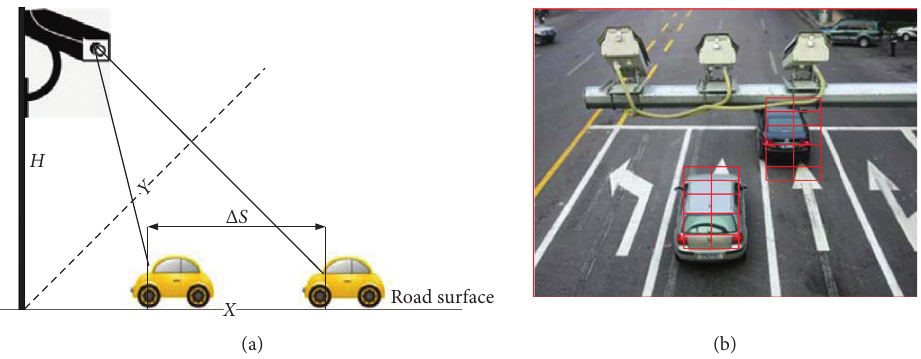
Figure 7: Schematic diagram of the spatial position of the camera and road vehicles (a) and example